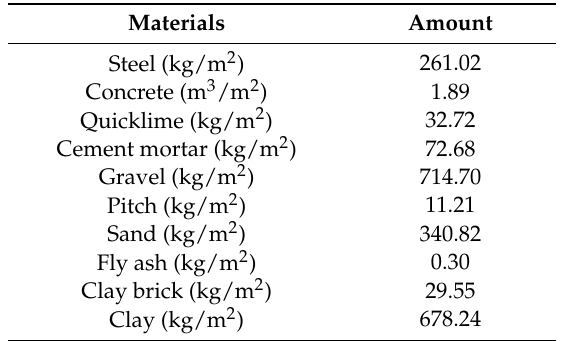
Table 1. The materials used in the fast track transportation project per unit